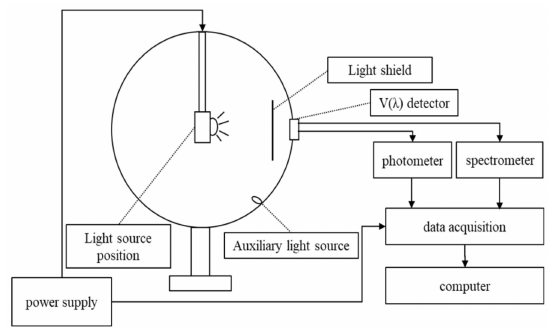
Figure 2. Systematic Illustration for the integrating sphere.